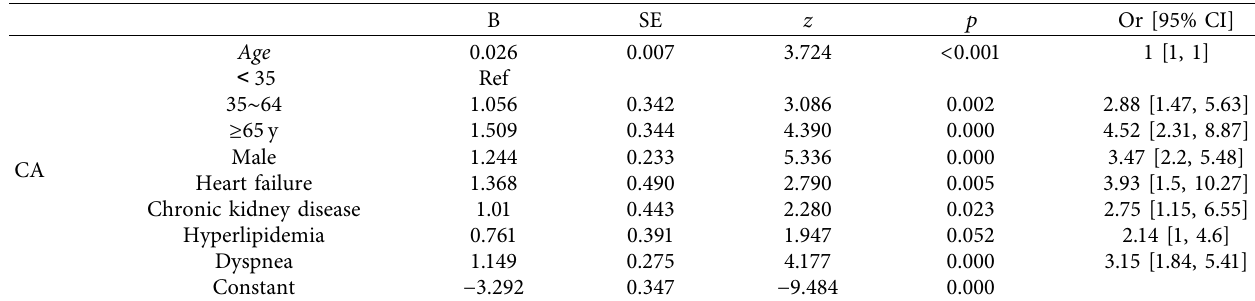
Table 3: Quick scoring model for